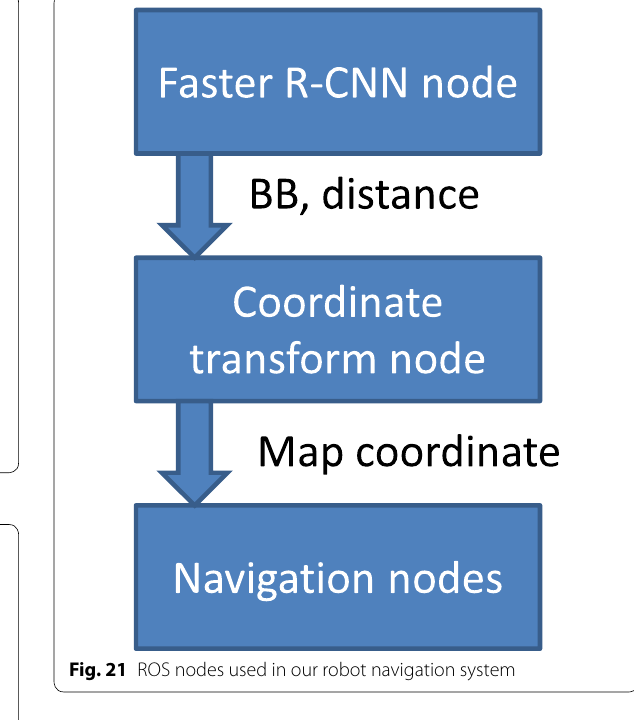
Fig. 21 ROS nodes used in our robot navigation system